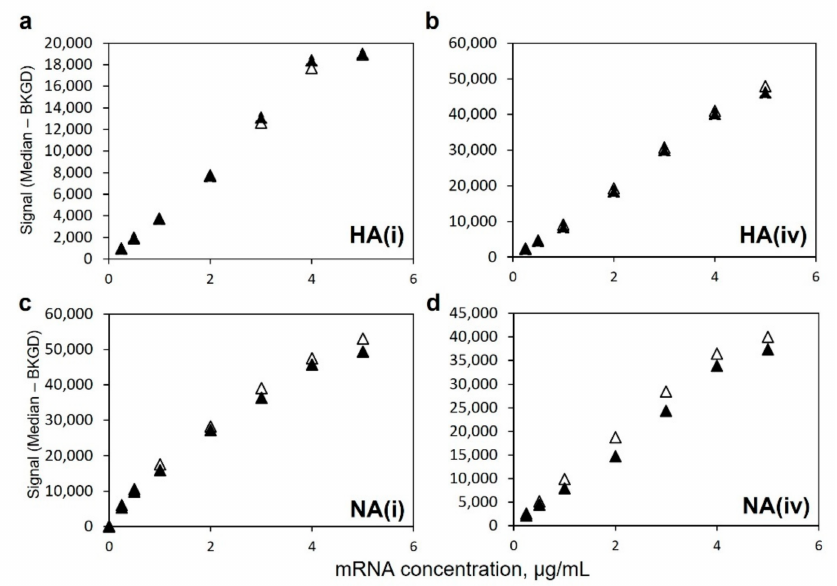
Figure 6. Similarity of response for monovalent ( (cid:78) ) and bivalent ( ∆ ) 8-point dilution series using polyT oligo detection label for LNP-encapsulated HA mRNA using ( a ) HA(i) coding region capture, ( b ) HA(iv) coding region capture, and for LNP-encapsulated NA mRNA using ( c ) NA(i) coding region capture, and ( d ) NA(iv) coding region